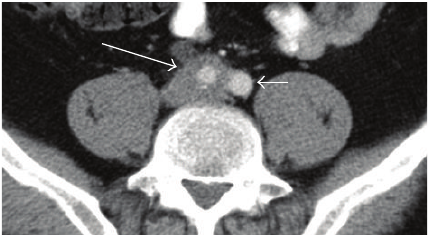
Figure 1: CAT scan axial view shows mural segmental thickening in common iliac artery (large arrow) and hydroureter (small arrow).